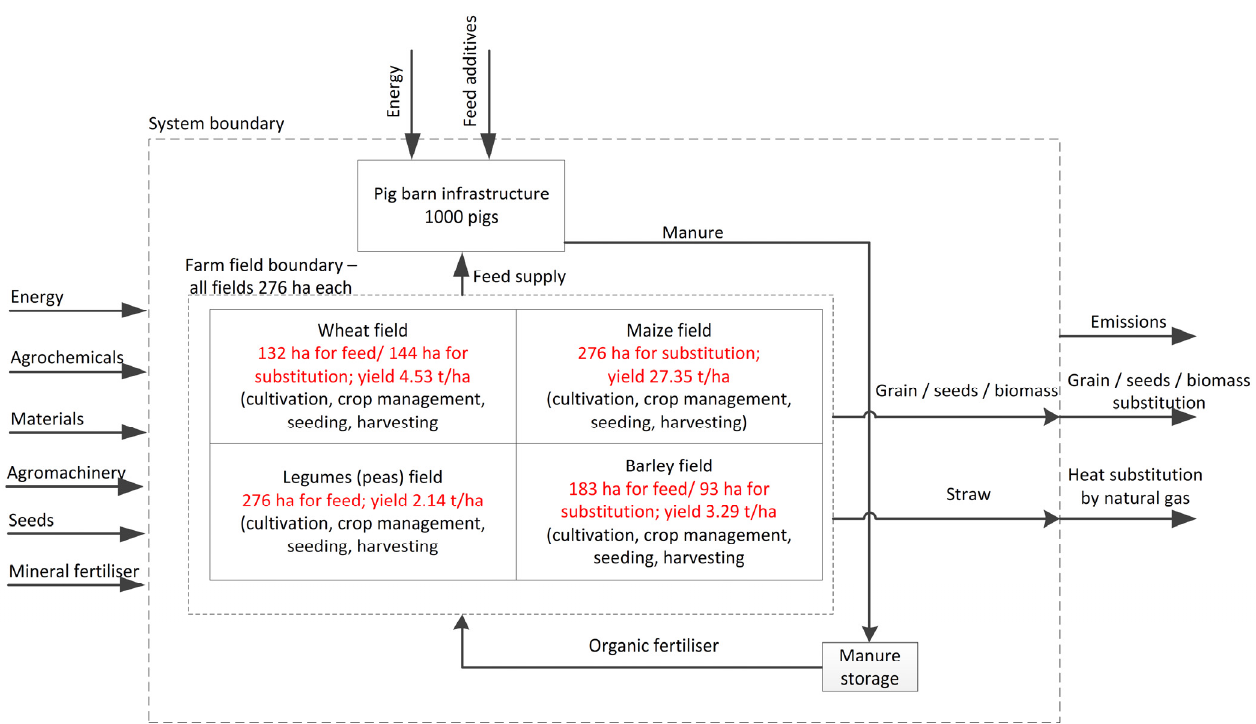
Figure 2. Schematic representation of the main processes and pathways considered for the pig farm in CS1.